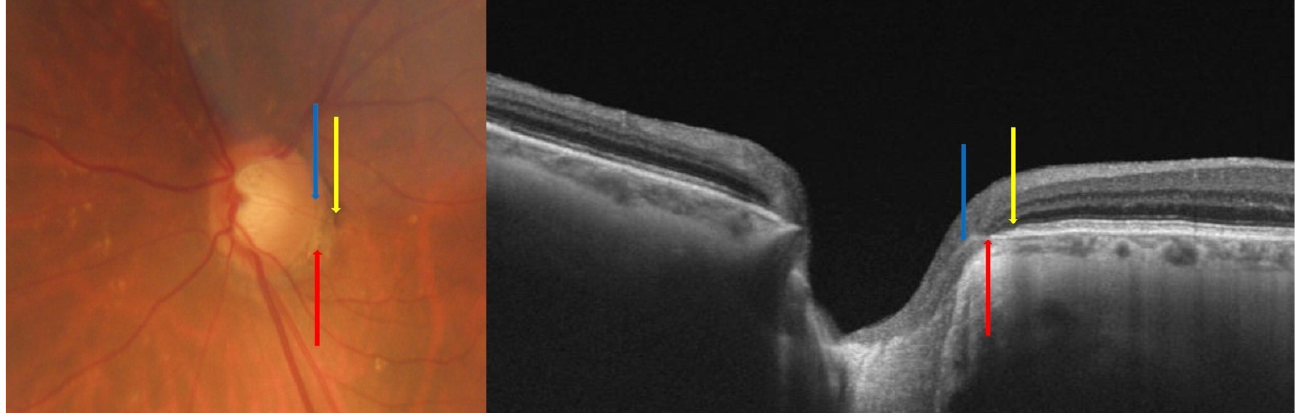
Figure 1. Fundus photography and optical coherence tomography of the peripapillary region of a myopic subject. The blue arrow represents the temporal optic disc margin, the red arrow represents the end of Bruch’s membrane (BM), and the yellow arrow represents the end of the retinal pigment epithelium (RPE). The distance from the temporal optic disc margin (blue arrow) to the edge of BM (red arrow) is defined as peripapillary atrophy (PPA) beta and the distance from the edge of BM (red arrow) to the end of RPE is defined as PPA alpha.